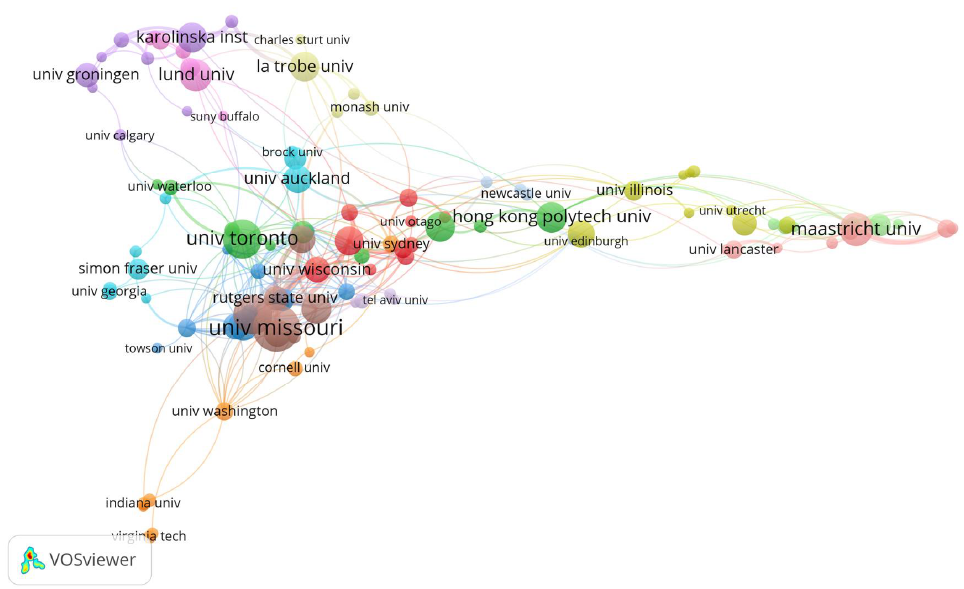
Figure 4. Network visualization of contributing Figure 4: Network visualization of countries